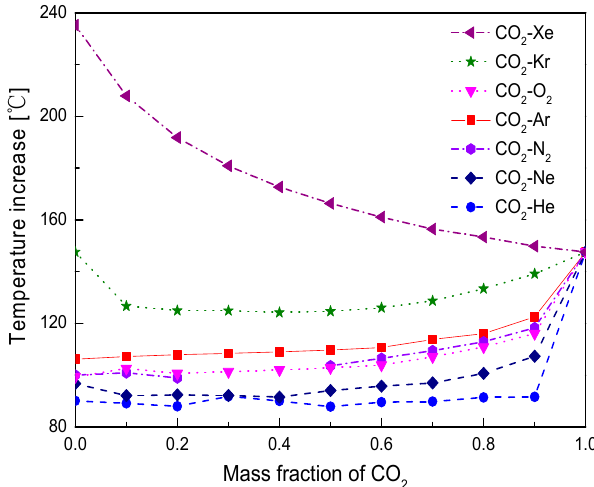
Figure 11. Temperature increase of mixtures in the primary heater.